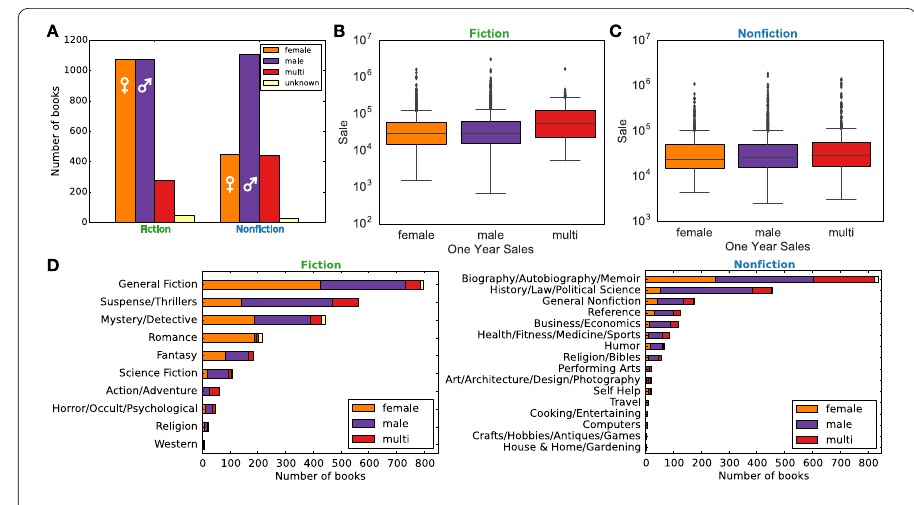
Figure 8 Bestsellersandgender . ( A ) The breakdown of the New York Times hardcover bestseller list by the author’s gender. Fiction bestsellers are equally likely to be written by female or male authors, while most nonfiction bestsellers are written by male authors. ( B ) One year sales of the fiction bestsellers written by different gender groups, ( C ) the same for nonfiction. A breakdown of the bestselling book categories by gender, fiction ( D ) and nonfiction ( E ). Median yearly sales for books written by different groups are indistinguishable. In fiction, romance genre is dominated by female authors, while male authors are